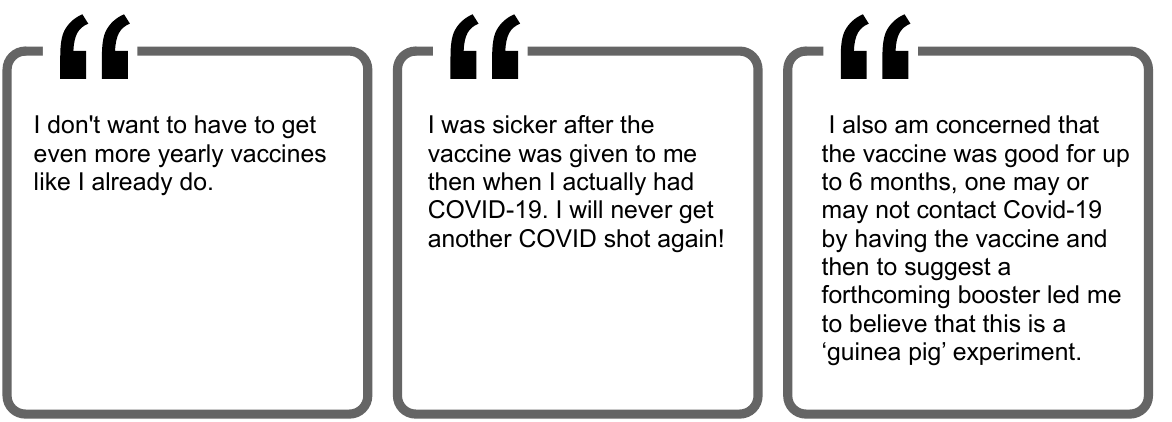
Figure 12. Participant perspectives regarding booster shots.